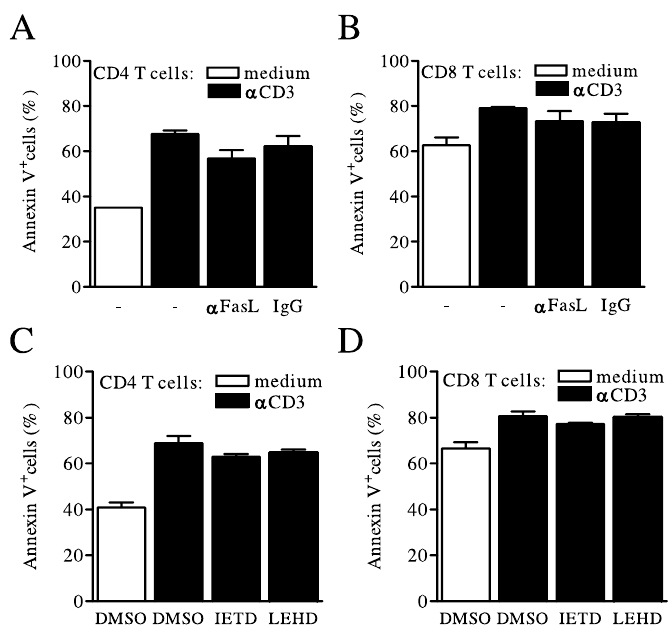
Fig. 3 – T-cell death pathways during L. major infection. Lymph node cells from infected (2 wk) mice were cultured with medium only (open bars) or stimulated with anti-CD3 (black bars) in the presence of anti-FasL or control IgG (A and B) or in the presence of zIETD, zLEHD or stock diluent DMSO (C and D). After 24 h, cultured cells were stained with anti-CD4, anti-CD8, and annexin V. Panels show percentages of apoptotic (annexin V + ) CD4 (A and C) and CD8 (B and D) T cells. Results are expressed as average and